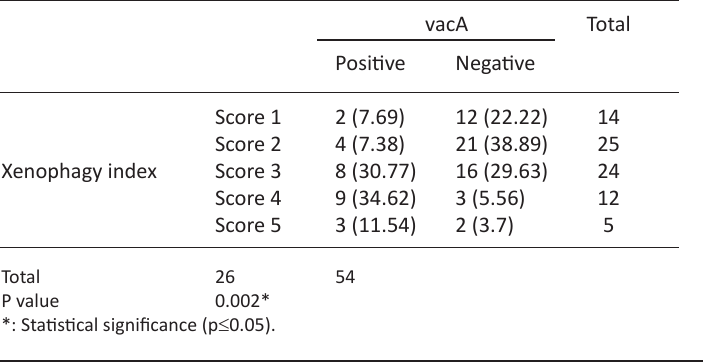
Table 3. Association between vacA expression and xenophagy index in gastric epithelial cells